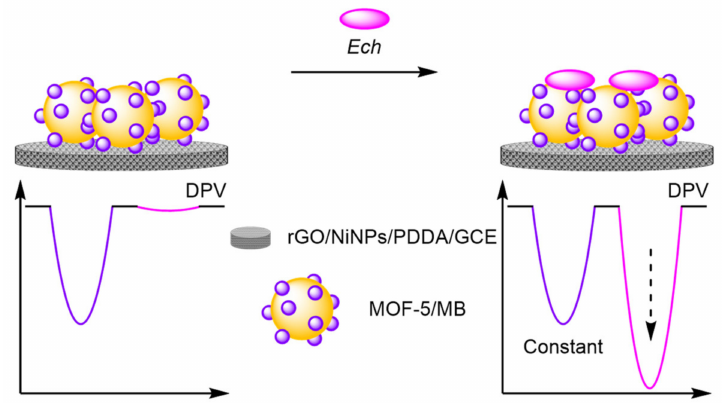
Figure 30. Schematic representation of a MOF-based modified electrode for the detection of echinacoside.